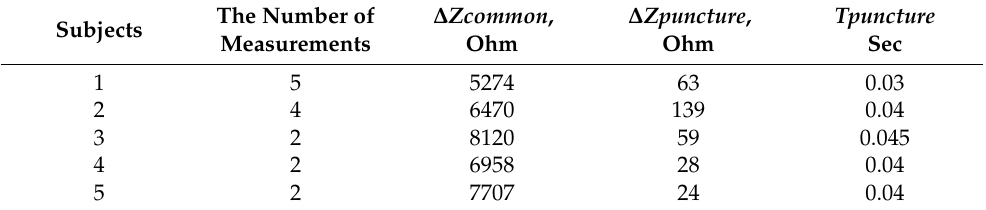
Table 3. Characteristics of electrical impedance recording during venipuncture.